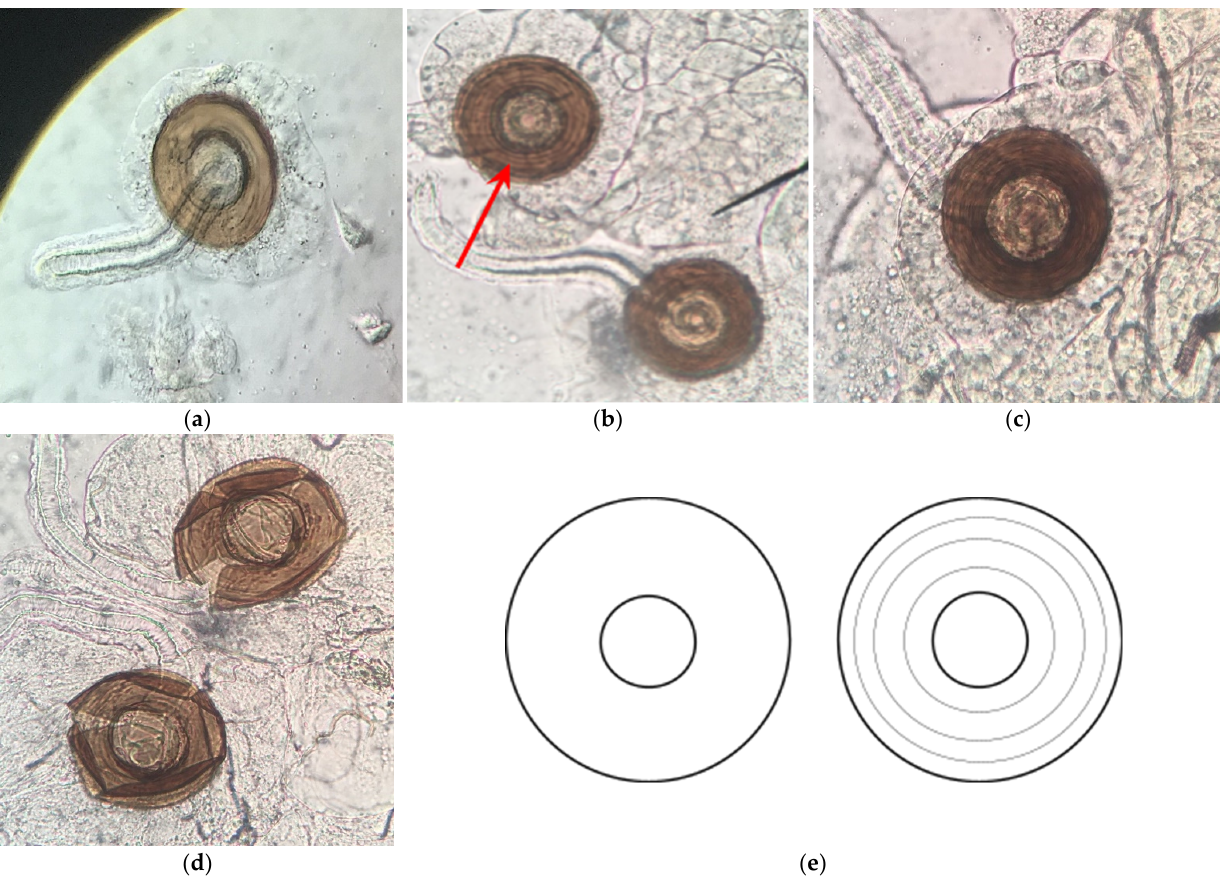
Figure 8. Spermatheca dissections at 400× magnification of D. melanogaster females exposed to ( a ) organic control medium within 4 h of eclosion, ( b ) Roundup ® Ready to Use at 2 g/L of glyphosate within 4 h of eclosion, ( c ) Roundup ® Ready to Use at 1 g/L of glyphosate within 2 h of eclosion, and ( d ) Roundup ® Super Concentrate at 1 g/L of glyphosate within 2 h of eclosion. The red arrow in pane ( b ) indicates one toroidal mass of sperm, which can be seen in all spermatheca we dissected. ( e ) Female D. melanogaster spermatheca representations: virgin (left) and mated (right). Table 5. Number of D. melanogaster female spermatheca observations per exposure treatment.